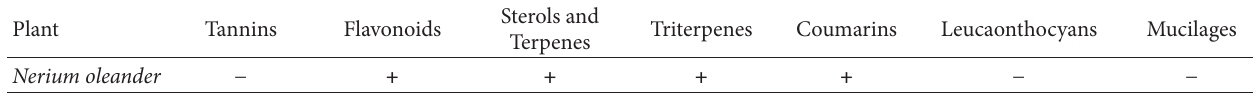
Table 1: Phytochemical screening of hydroethanolic extract of plant N. oleander . Plant